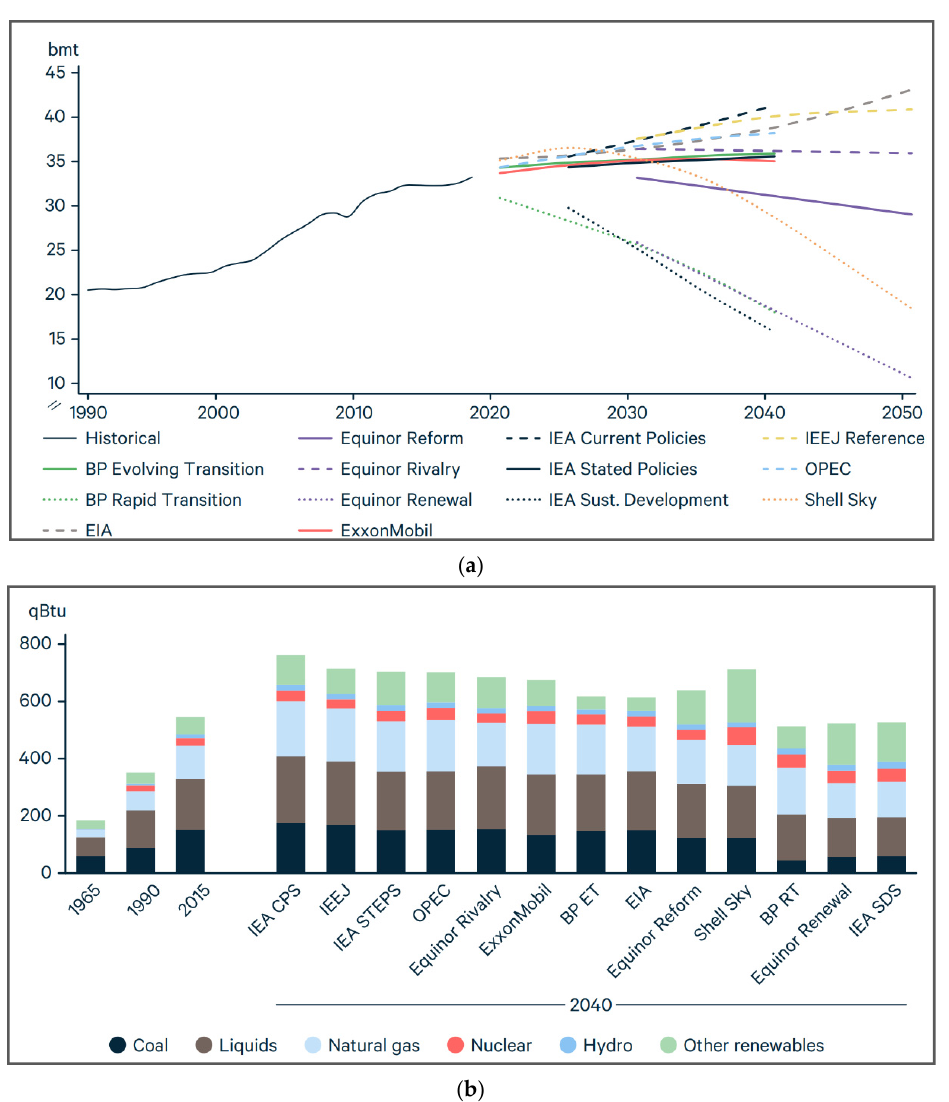
Figure 1. ( a ) Net global carbon dioxide emission history and predictions based on evolving energy policies around the world; ( b ) net global electricity production history and predictions based on evolving energy policies around the world [2].